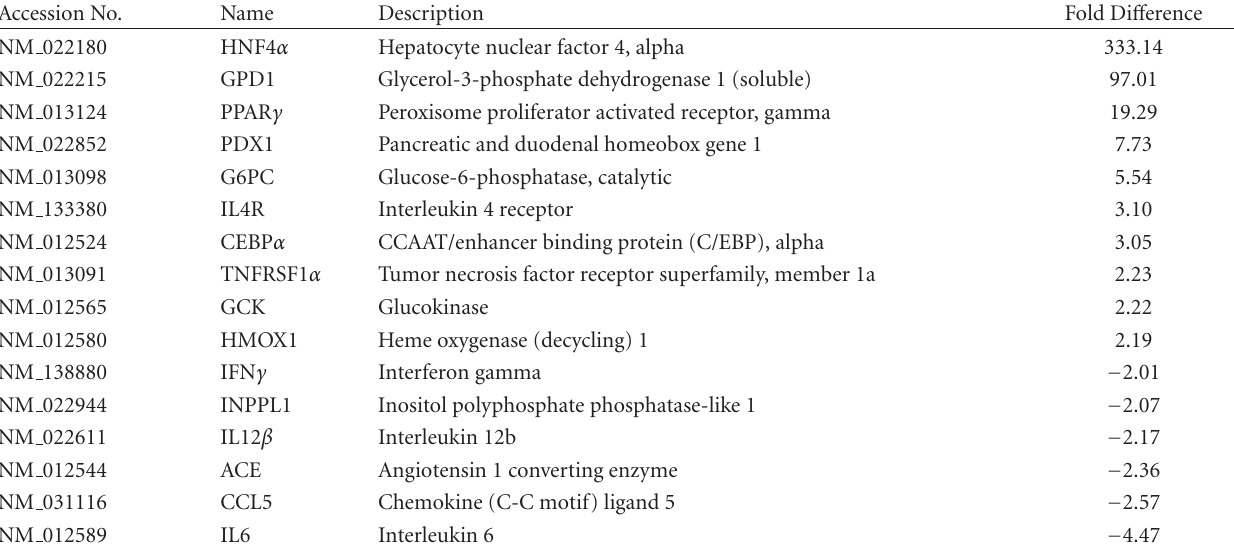
Table 1: Genes di ff erentially regulated in rat primary hepatocytes by adenovirus HNF4 α (Ad-HNF4 α ) relative to Ad-GFP infection according to the superarray